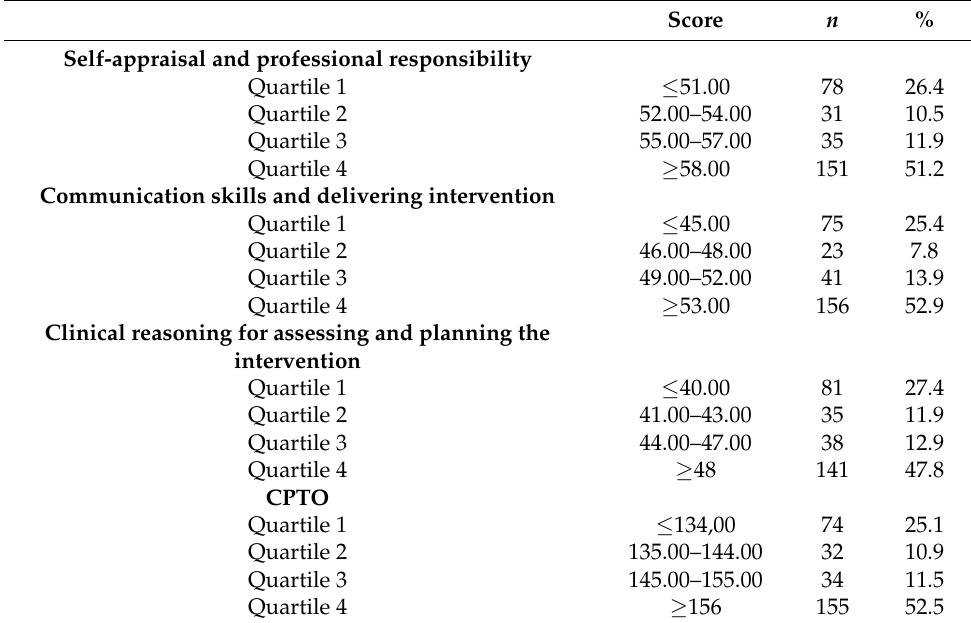
Table 5. Quartiles scoring for each factor in the